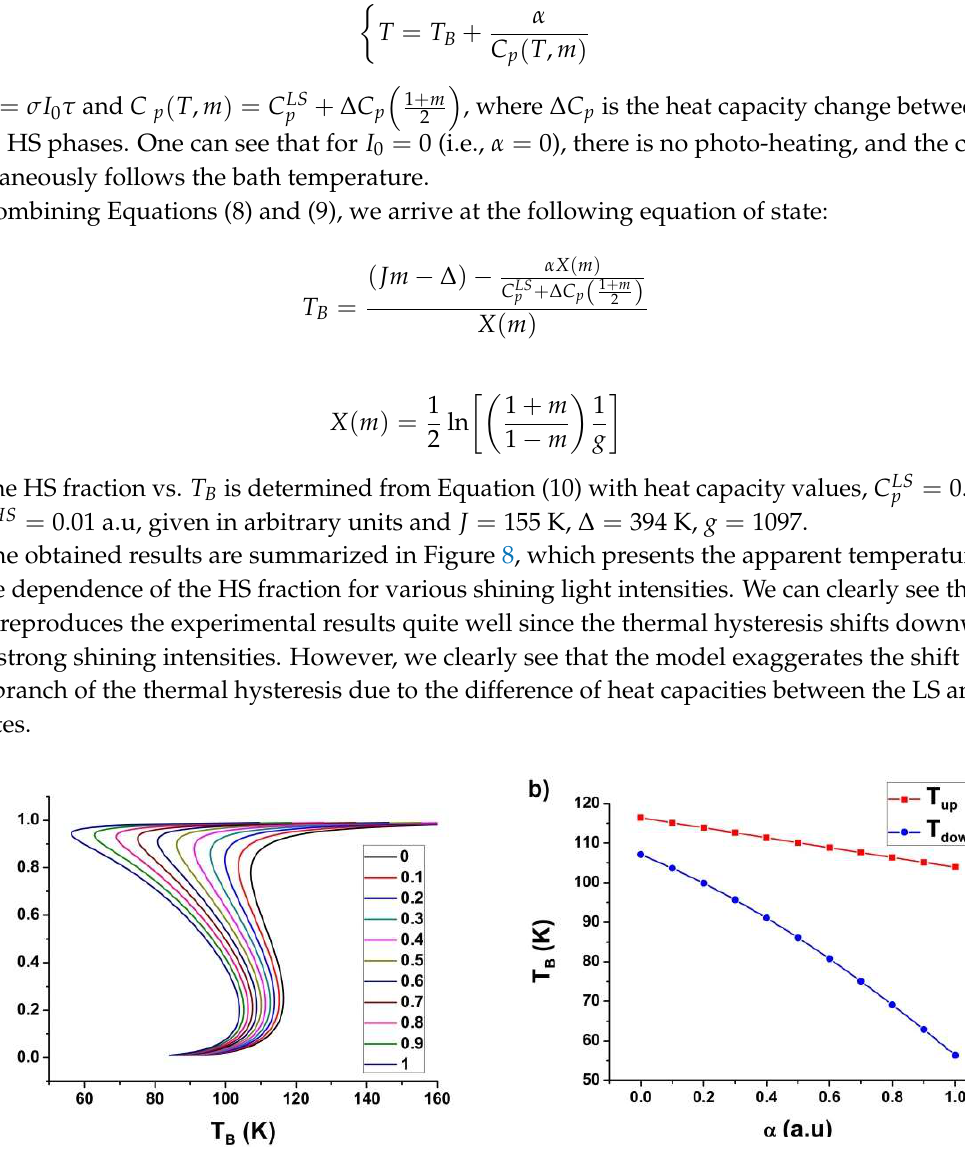
Figure 9. ( a ) Simulated bath-temperature (T B ) dependence of the HS fraction under various light intensities (from 0 to 1, given in arbitrary units) for, Δ𝐶 (cid:3043) = 0 , showing a monotonous linear shift of the hysteresis loop. ( b ) Light intensity dependence of the upper and the lower transition temperatures of the thermal hysteresis leading to parallel lines. Used parameter values are: 𝐽 = 155 K , Δ = 394 K , 𝑔 = 1097 , 𝐶 (cid:3043)(cid:3013)(cid:3020) = 0.1 a.u, and 𝐶 (cid:3043)(cid:3009)(cid:3020) = 0.1 a.u .